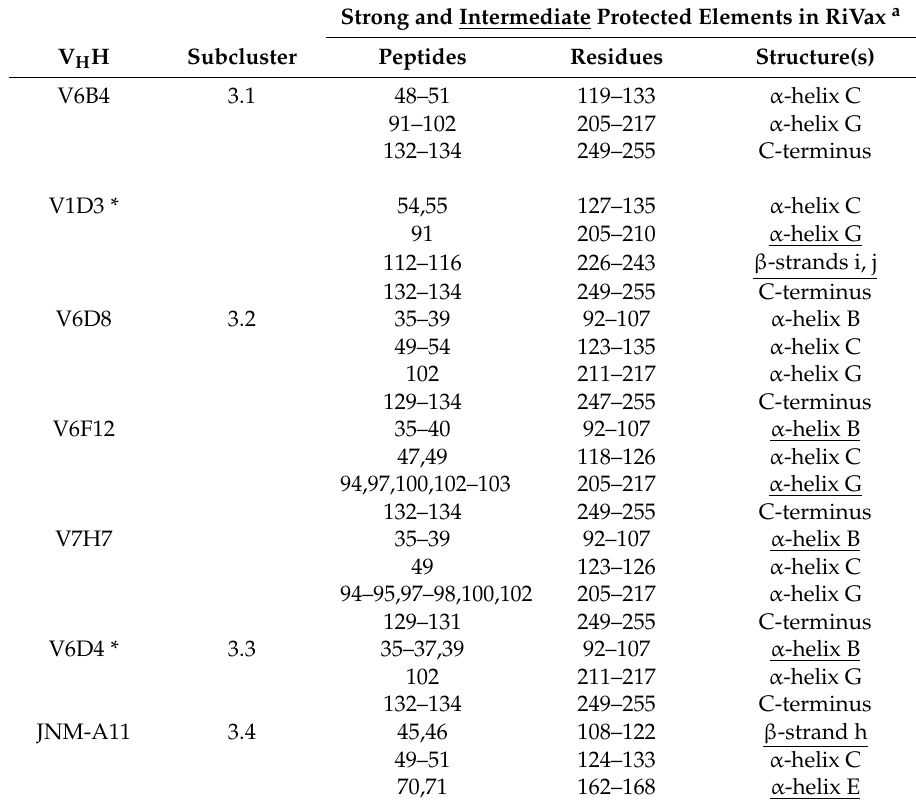
Table 3. Localization of epitopes on RiVax recognized by representative Cluster 3 V H